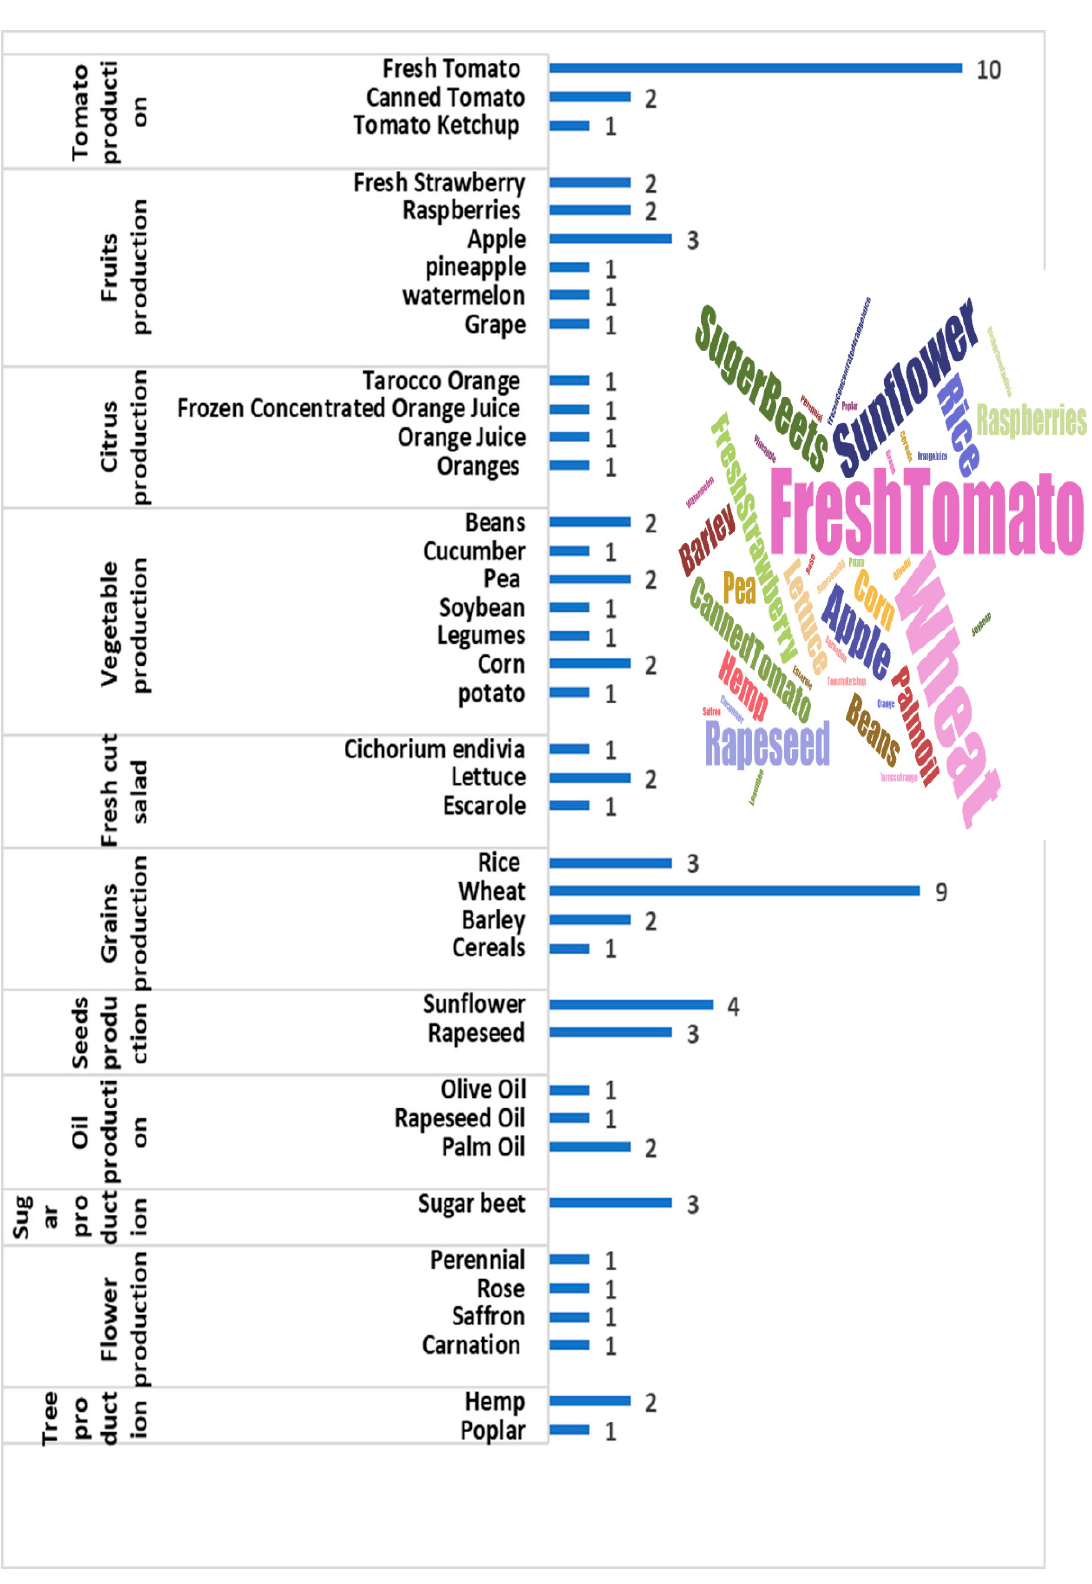
Figure 7. Common agricultural products used in LCA studies.